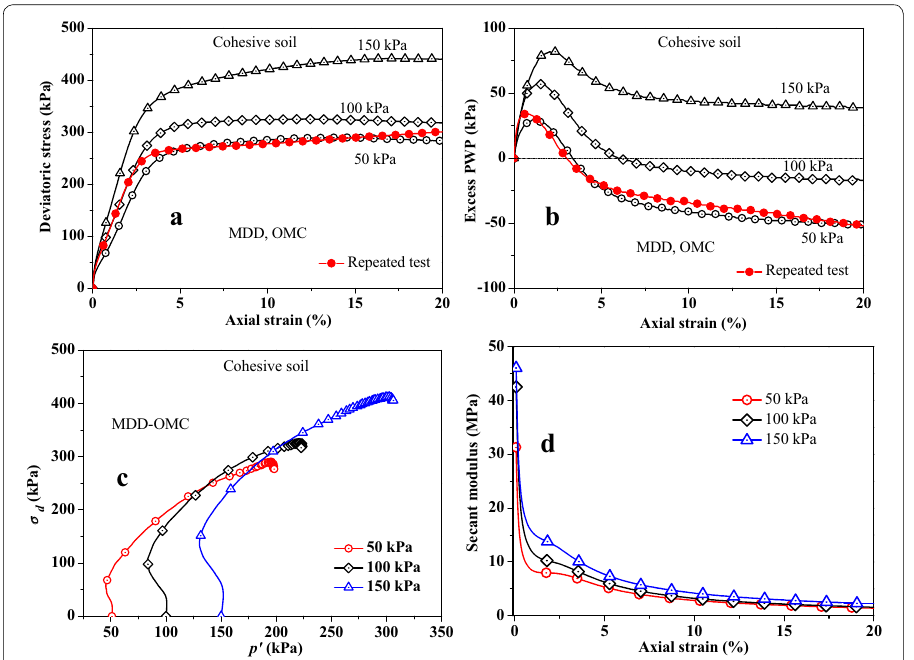
Fig. 9 Influence of σ ′ c on the response of cohesive RS subjected to monotonic loading a stress–strain, b excess PWP, c stress-path, d secant